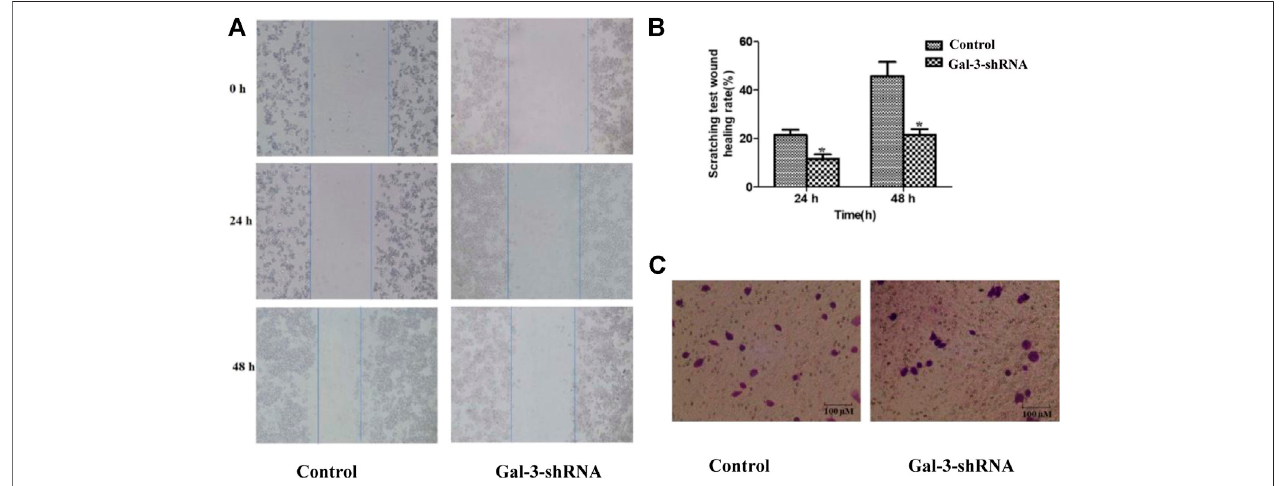
FIGURE 3 | Low expression of Gal-3 inhibits metastasis of ICC cells. The impact of Gal-3 upon the invasion and metastasis ability of ICC cells was examined by wound healing assay (A, B) and Transwell assay (C)